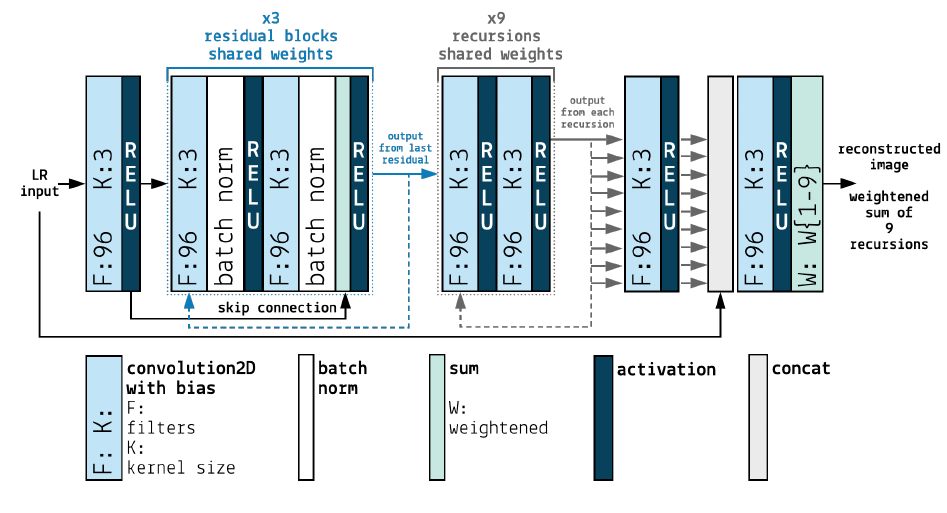
Figure 4. Architecture of the proposed Convolutional-based Super Resolution model used in the study for enhancing thermal sequences from which respiratory rates were